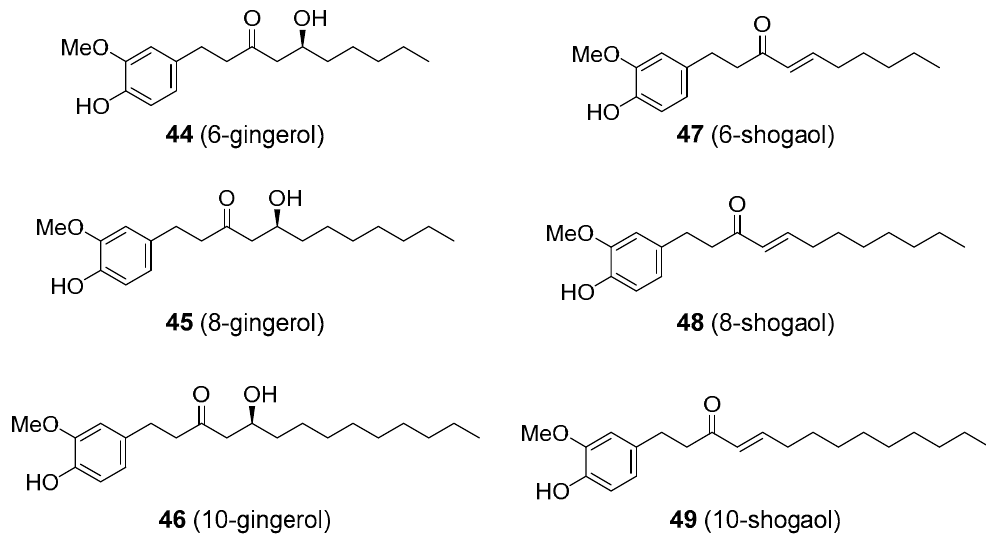
Figure 12. Compounds related to the diarylheptanoid pathway.